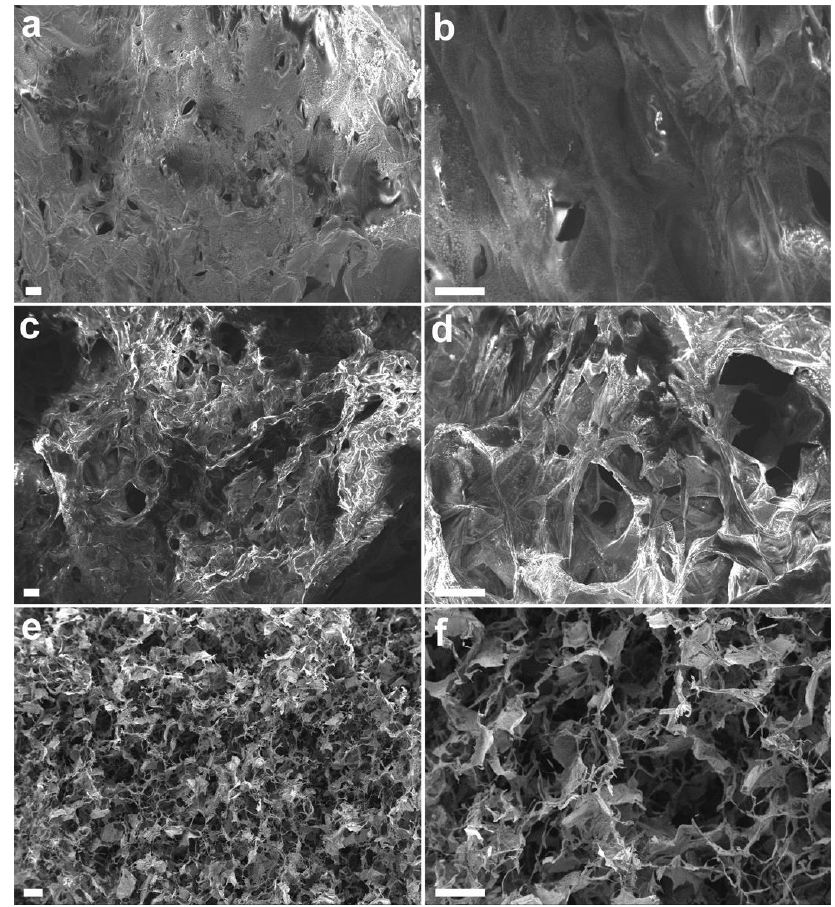
Figure 1. SEM images at lower ( a , c , e ) and higher ( b , d , f ) magnification of the A-C hydrogels with different agarose concentration: ( a , b ) 0.5%; ( c , d ) 0.25%; ( e , f ) 0.125%, respectively. Type I collagen is always 0.02%. Scale bar is 100 µm.